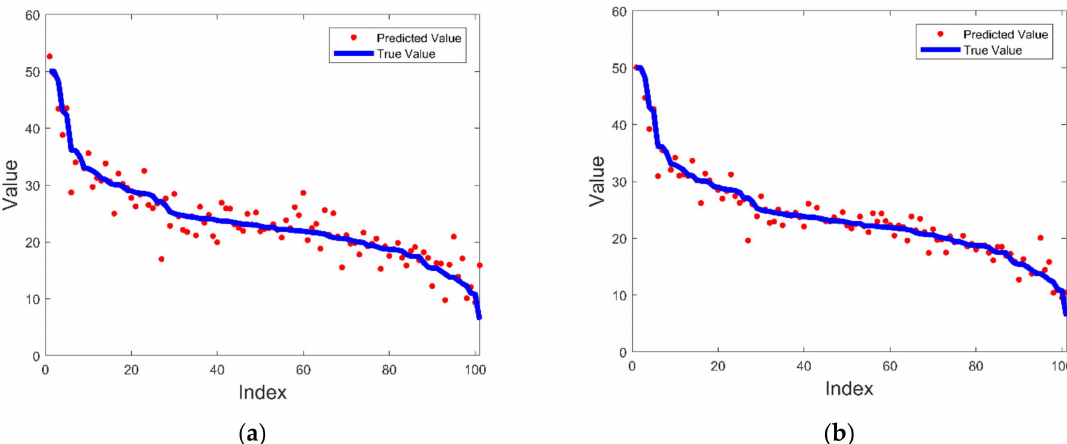
Figure 10. Boston housing dataset prediction results obtained with the models fused with the numeric-type spatial weight matrix: ( a ) conventional LS-SVR model; ( b ) Geo LS-SVR model.